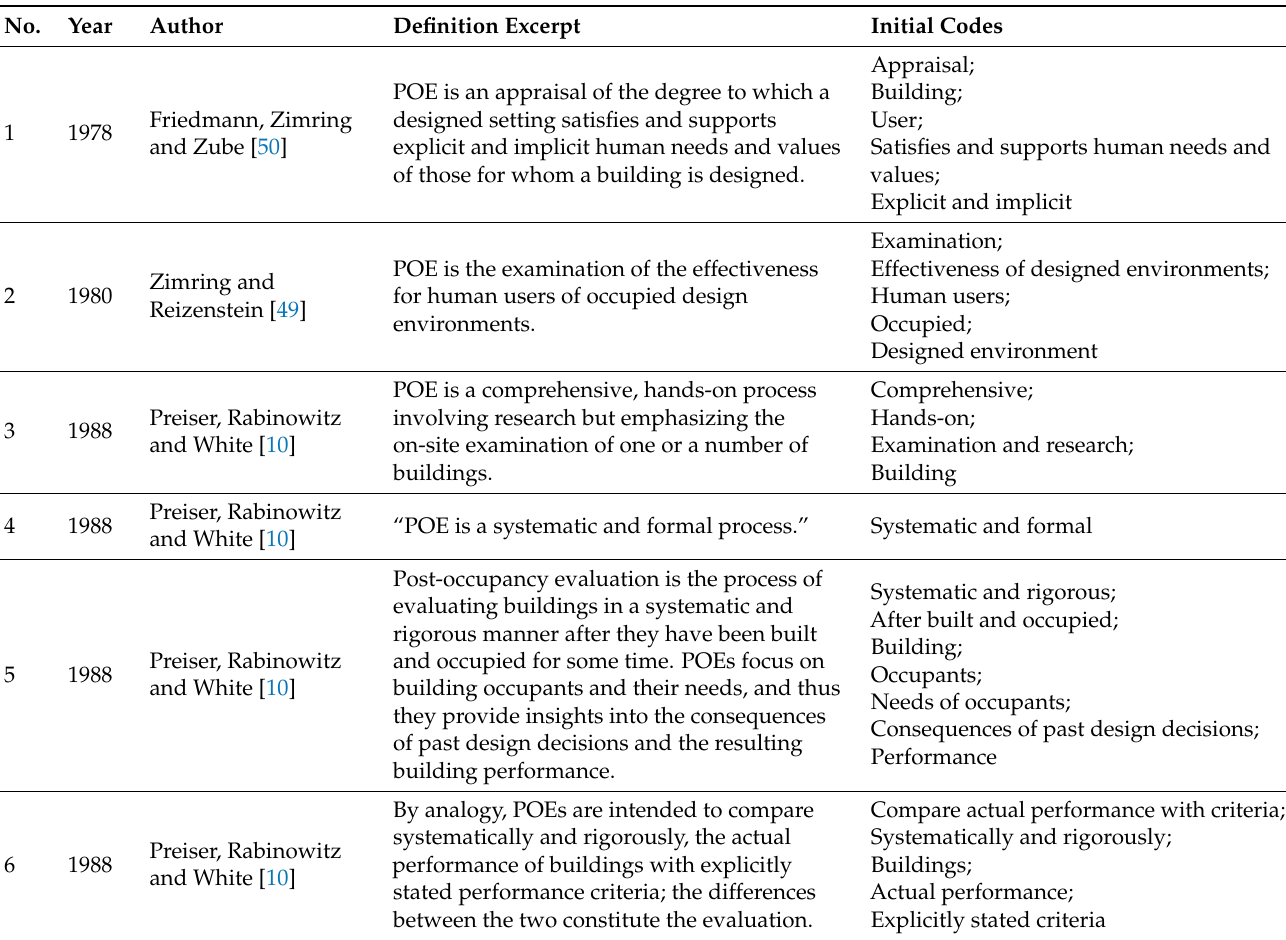
Table A1. Open Coding Result of POE